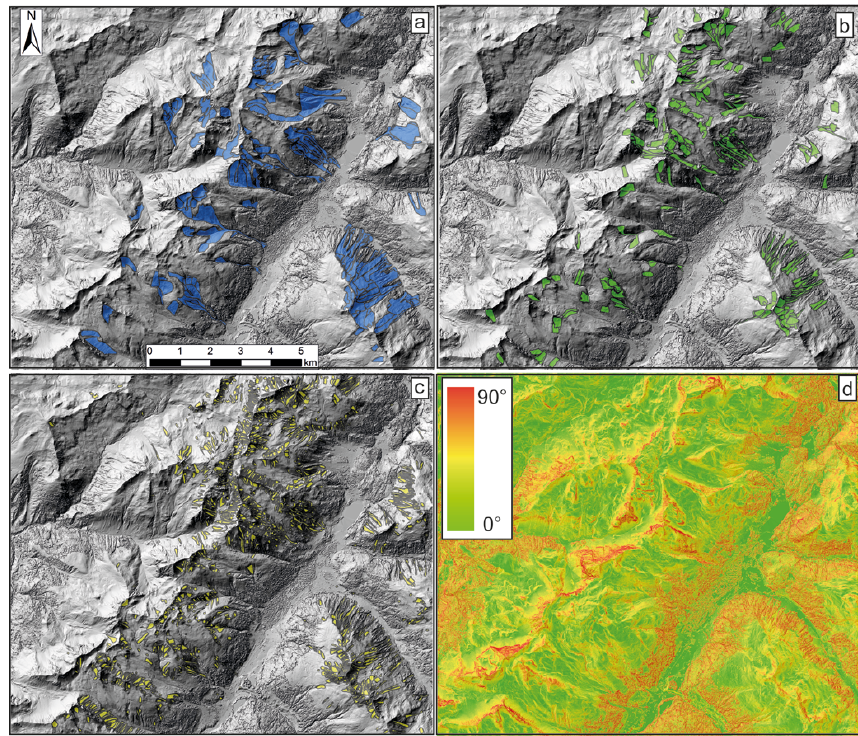
Fig. 2. Reference avalanche events used for validation of the potential avalanche release zone identification algorithm. (a) Large avalanches, n = 197; (b) medium avalanches, n = 288; (c) small avalanches, n = 4361; (d) slope calculated from the summer